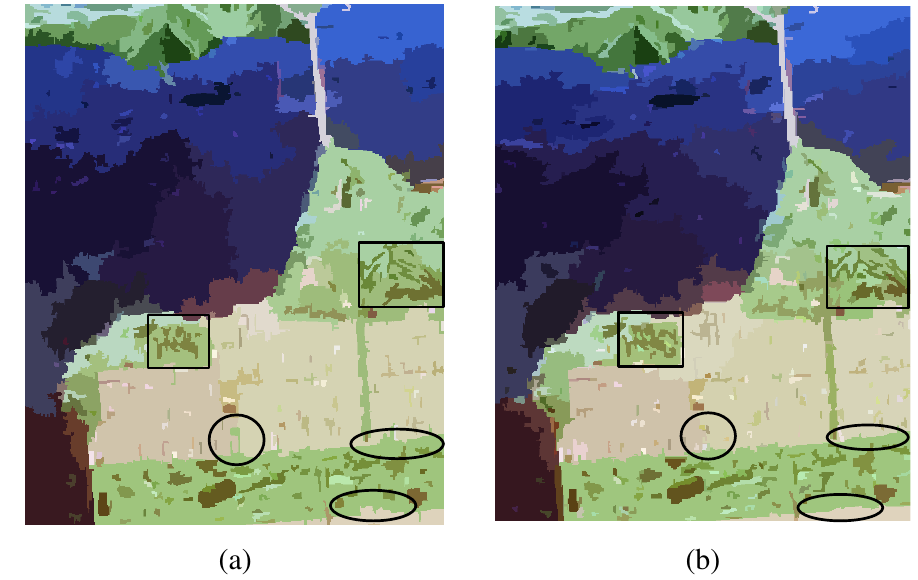
Figure 21. The segmentation results of the San Francisco image: ( a ) the original SRM algorithm with Q = 160; ( b ) SRM + RHLBP with Q = 160, T = 35, M = 0.12, N = 20.